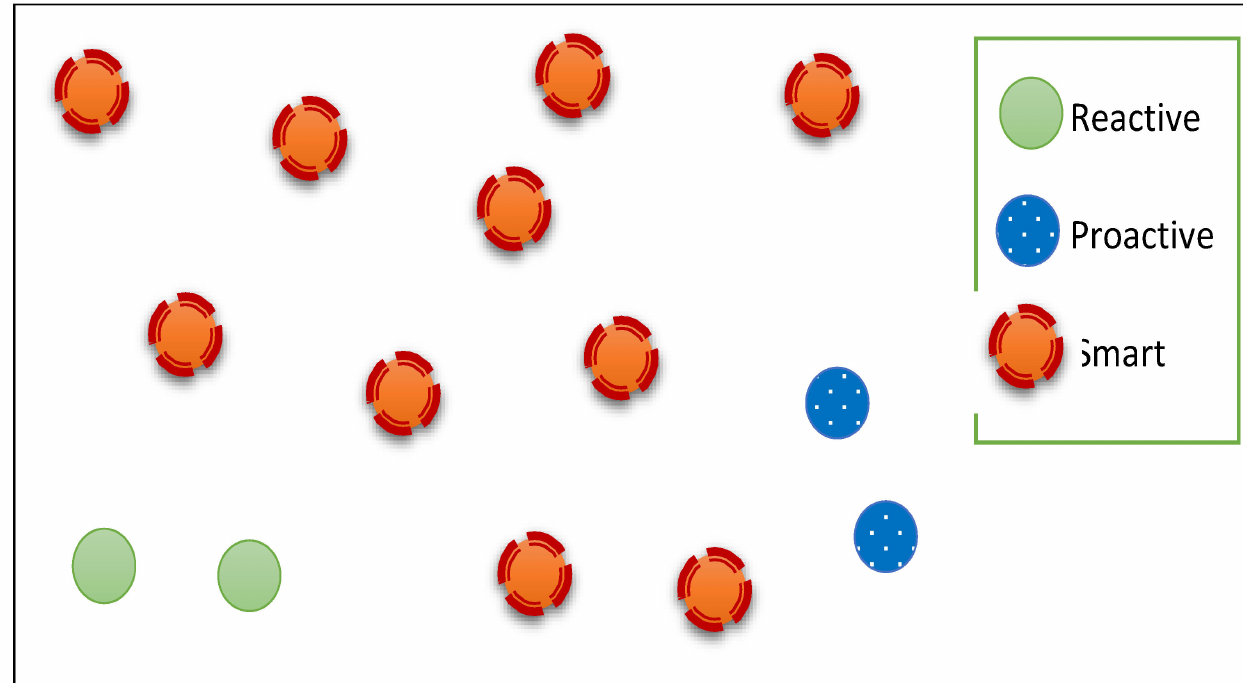
Figure 6. Most of the network nodes are smart